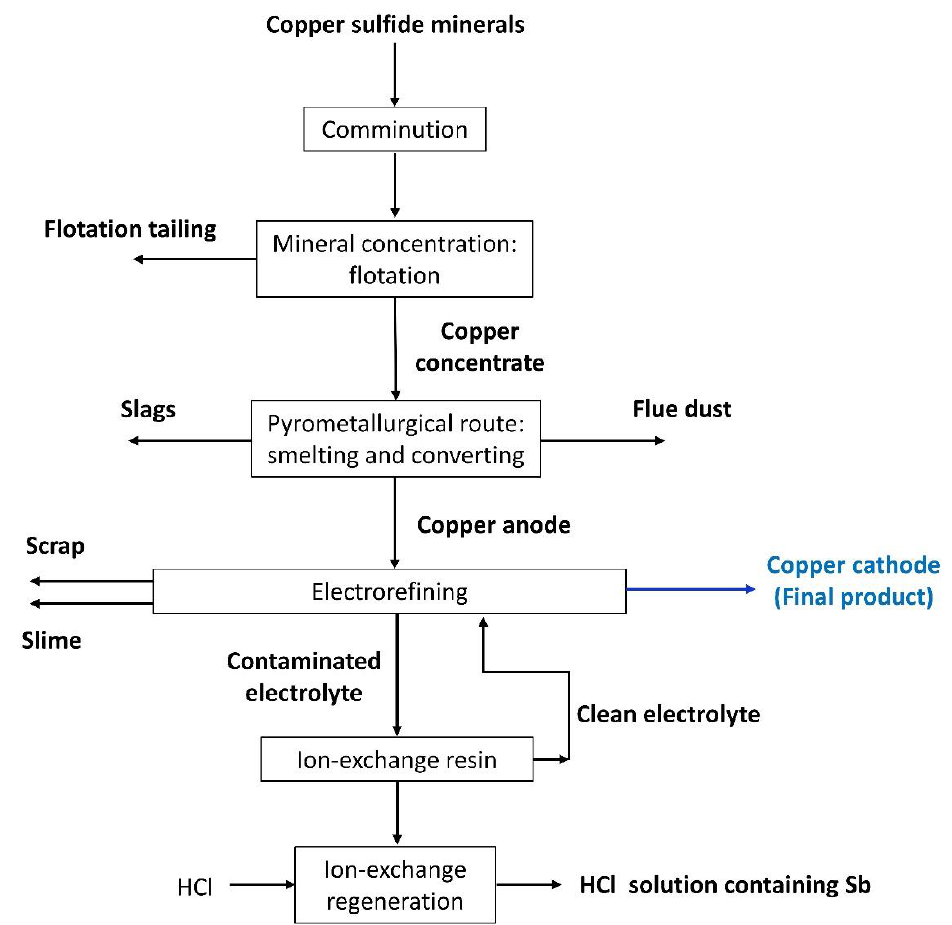
Figure 1. Flowchart of the copper production from sulfide minerals showing the inputs and outputs of the main process stages.